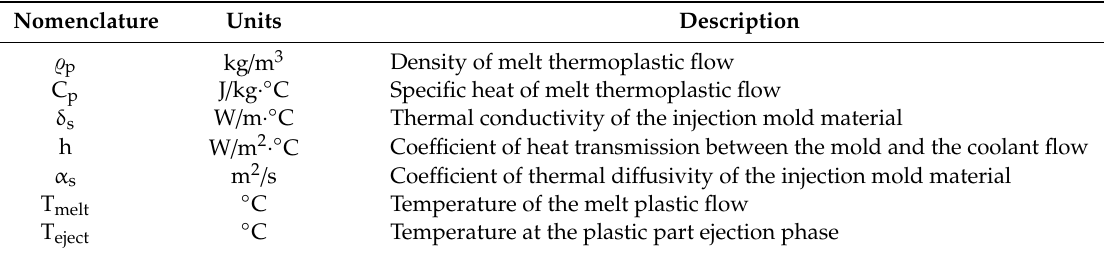
Table A2. Technological variables for the thermal exchange between the thermoplastic material and the injection